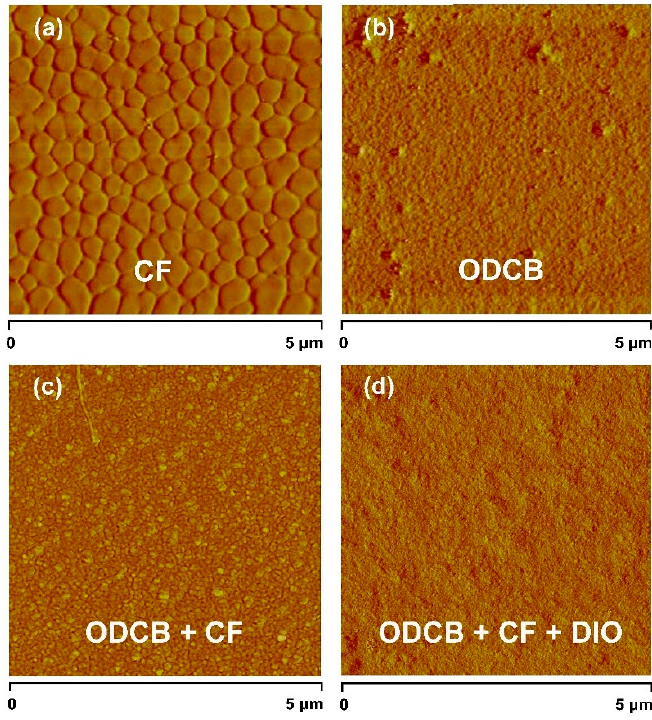
Figure 7. AFM phase image of PSTDPP/PC 71 BM blend film prepared by different solvents. ( a ) CF; ( b ) ODCB; ( c ) ODCB:CF (2:1); and ( d ) ODCB:CF (2:1) with 2.5% DIO. The size of the AFM image is 5 μ m × 5 μ m.